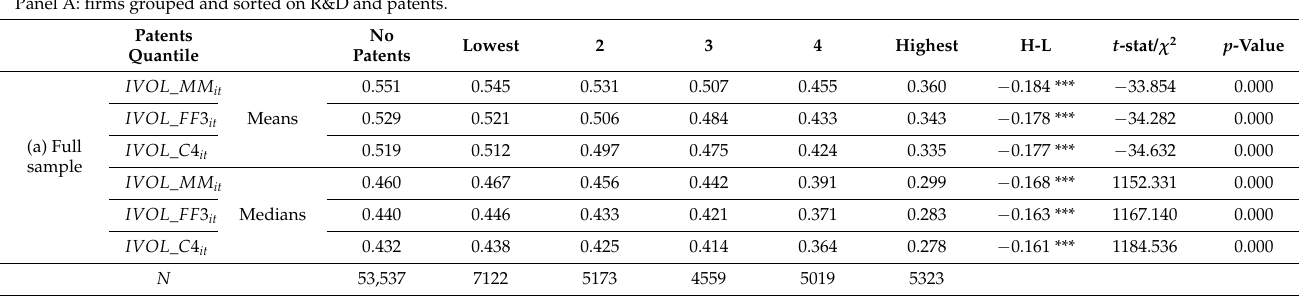
Table 5, panel A reports the differences in the means and medians of subsamples double-sorted based on R&D spending and PAT . Panel B reports double sorting based on PAT and DISP . Table 5, panel A (a) shows the difference in the means and medians of the entire sample. The results indicate that IVOL is negatively correlated to PAT . The lowest patent quantile has an average (median) IVOL _ MM of 0.545 (0.467) compared to 0.455 (0.391) in the highest quantile. The difference between the two averages is significant at the An important observation is that the mean (median) IVOL monotonically declines as the number of patents increases across all R&D quintiles. These results provide preliminary evidence that IVOL is negatively correlated to patents after controlling for R&D spending, supporting our first hypothesis. Additionally, this shows that R&D and patents capture different dynamics of the innovation process. These results are consistent with those of previous studies (e.g., Czarnitzki and Toole 2011). Table 5. Double sorting. Panel A reports the average (median) IVOL of firms grouped and sorted based on R&D and patent quantiles over the sample period. The reported t -statistic (chi-squared) is for the difference between the mean (median) of the average IVOL in the lowest and highest quantiles. Panel B reports the comparison means (median) test based on the variance of analyst forecasts and patent quantiles. The sample period is from 1982 to 2015. *** denotes that the difference between the highest and the lowest quantile is significant p -value at the 1%